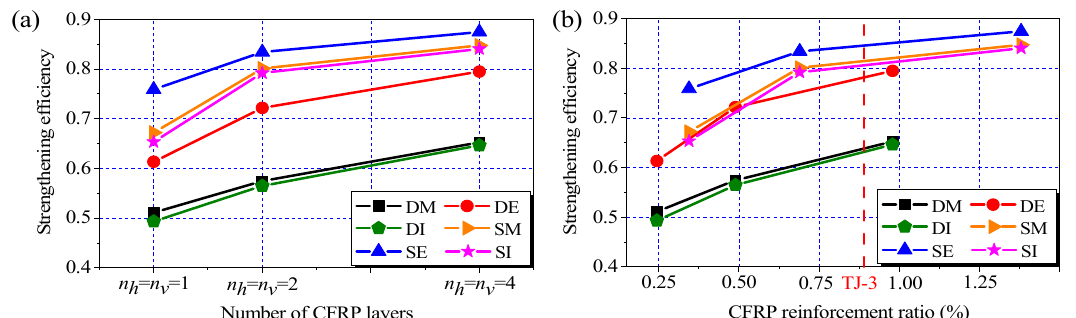
Number of CFRP layers Figure 7. Effect of the CFRP amount applied to the joint panel. ( a ) Strengthening efficiency versus number of CFRP layers; ( b ) Strengthening efficiency versus CFRP reinforcement